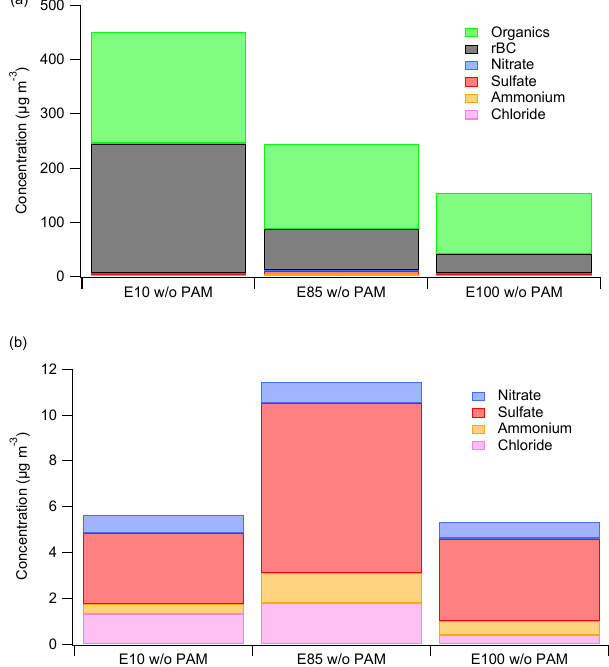
Figure 2. The chemical composition of the primary particulate emissions for E10, E85 and E100 (a) . The concentrations of the inorganic ions (b)